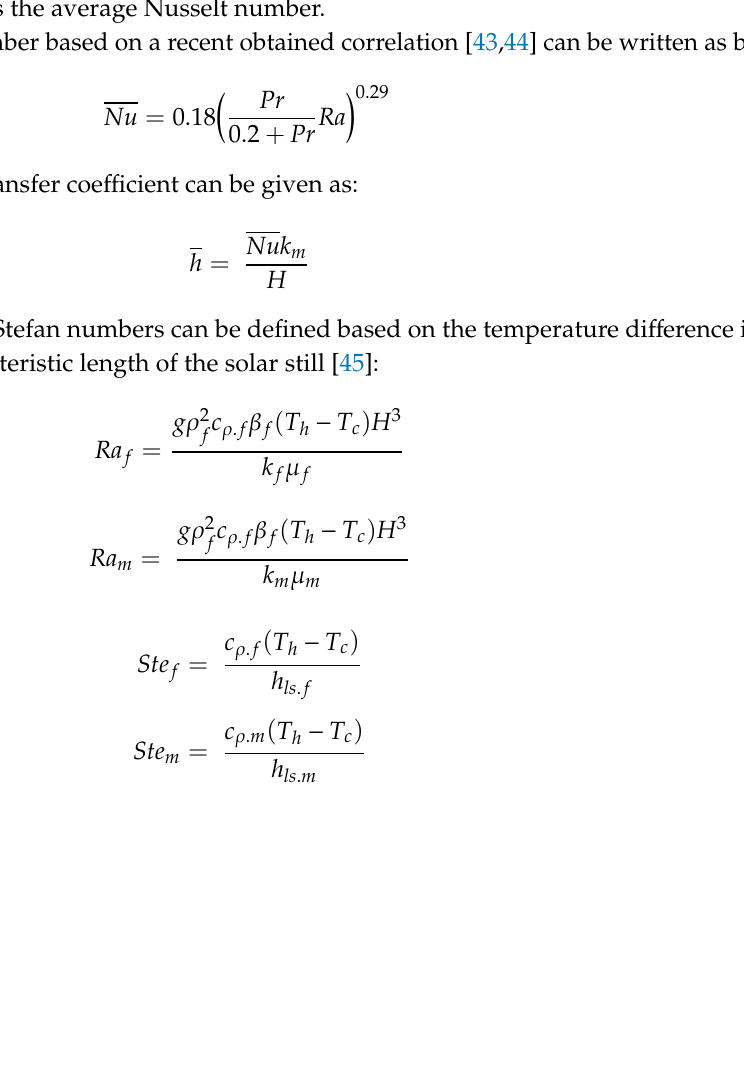
8 of 14 Figure 6. Comparison between temperatures in the presence and absence of PCM and nano-PCMs. The distillation amount is the primary factor in determining the performance of a solar desalination system. The volume of the existing water varies due to different utilized nanocomposites in solar still system. Figure 7 illustrated the produced fresh water per day time. The